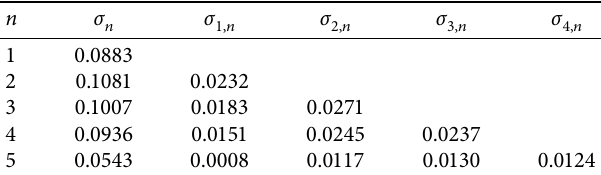
Table 17: Basic belief of risk information fusion and